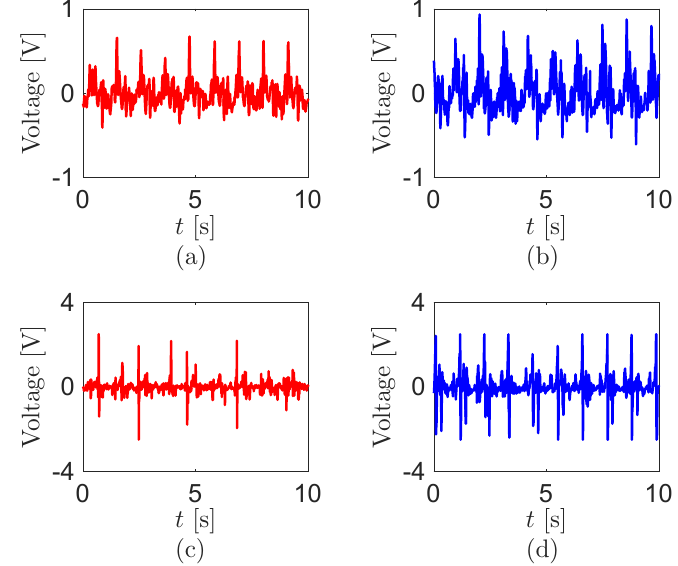
Figure 2. Sensor voltage outputs during walking at the ( a ) left hip; ( b ) right hip; ( c ) left knee; and ( d ) right knee. The test walking velocity is